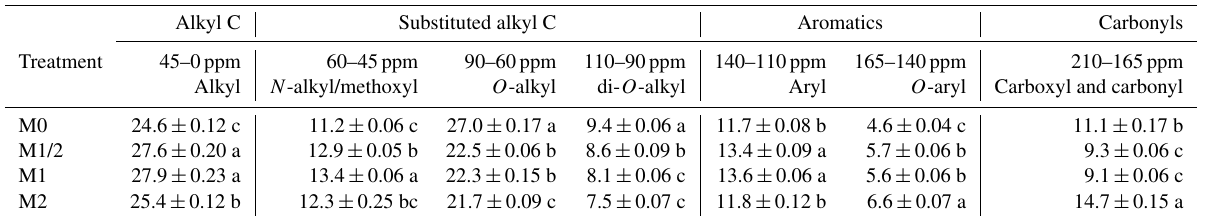
Table 5. Percentages of total special spectral areas of different functional groups obtained by quantitative CPMAS 13 C-NMR for soil samples from grassland soil with different mowing frequencies (%).